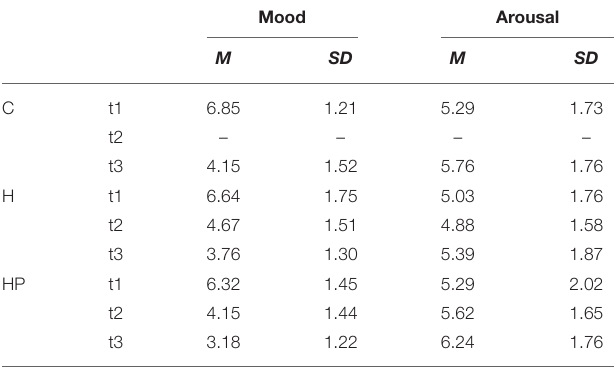
TABLE 1 | Participants’ mood and arousal at three different times (t1, t2, t3) by condition.